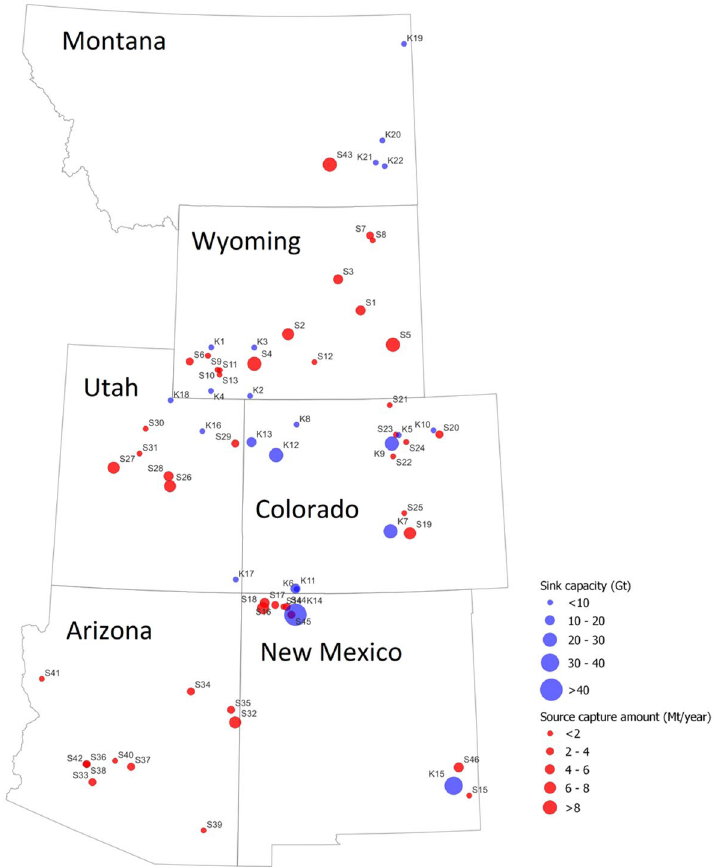
Figure 8. A map of CO 2 sources and sinks for the I-West case study. The blue circles indicate the locations and storage capacities of CO